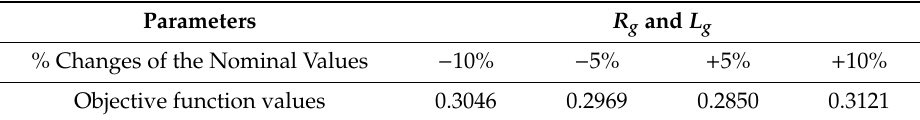
Table 6. Fitness values under varied parameter